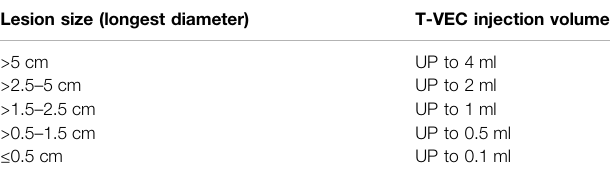
TABLE 3 | Tumor volume determination for T-VEC administration. Lesion size (longest diameter) T-VEC injection volume